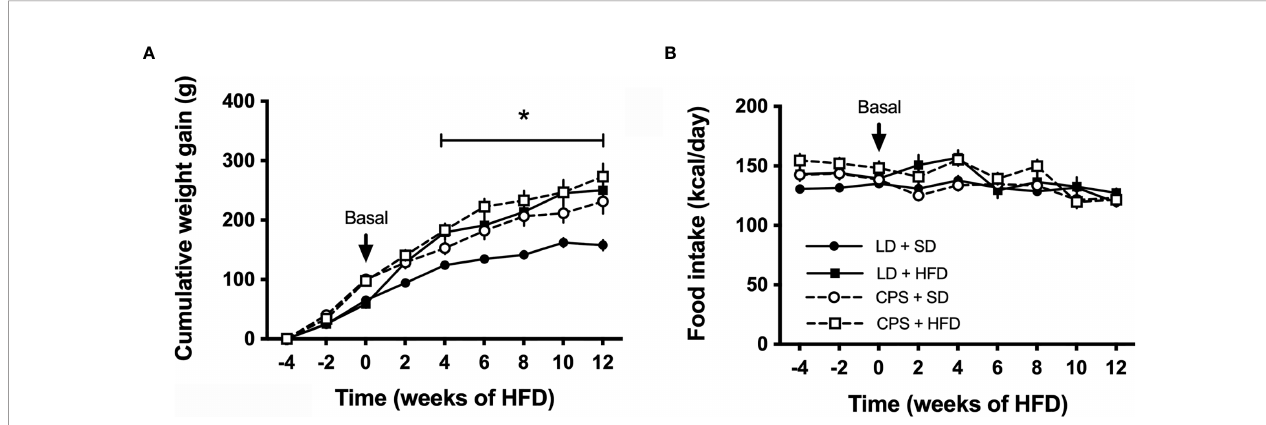
FIGURE 2 | Effects of gestational chronic phase shift of photoperiod on (A) cumulative weight gain and (B) food intake of rats fed with standard diet (SD) and 45% high-fat diet (HFD) for 12 weeks. Data are mean ± SEM. Solid line (LD): adult offspring gestated under control photoperiod; dashed line (CPS): adult offspring that had been gestated under chronic photoperiod shift; circles: adult offspring fed with standard diet Prolab ® RMH 3000; squares: adult offspring fed with HFD. n = 8 per group. *LD + HFD; CPS + SD and CPS + HFD are different from LD + SD ( p < 0.05 pairwise comparison at each time point with Bonferroni